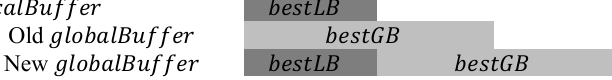
Fig. 6. Update scheme for global memory buffer